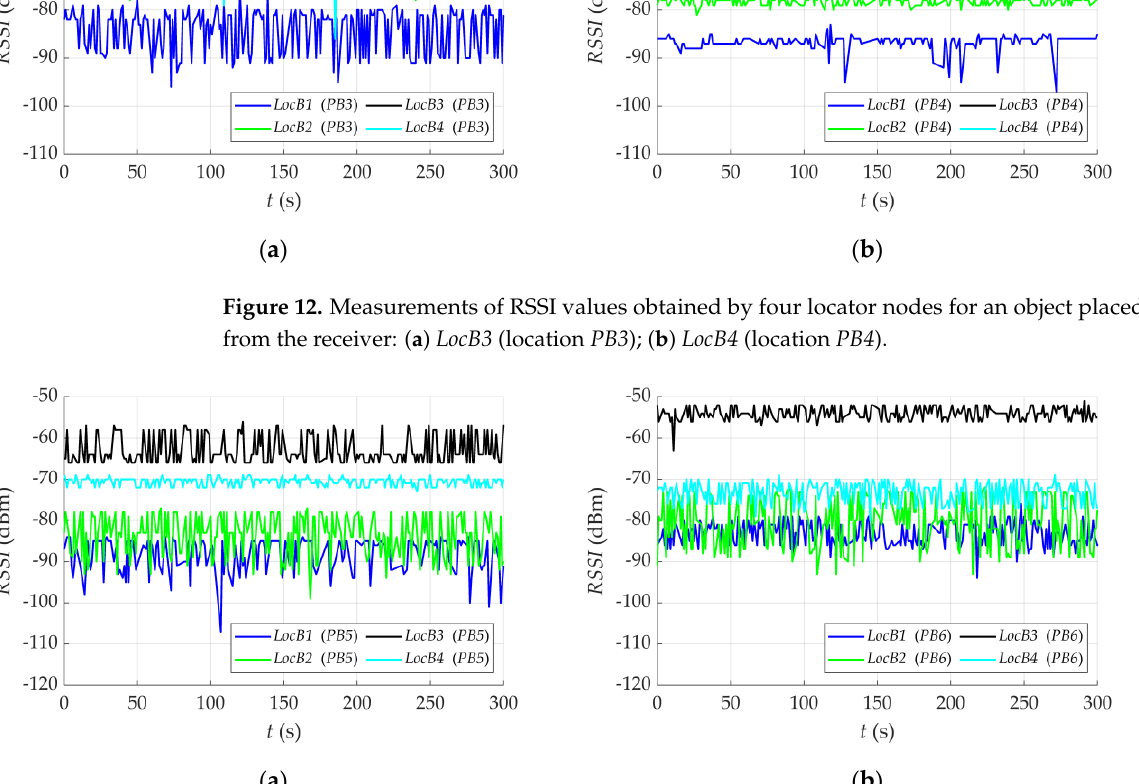
Figure 13. Measurements of RSSI values obtained by four locator nodes for an object placed in front of the LocB3 receiver at a distance of ( a ) 2.5 m (location PB5 ); ( b ) 1.0 m (location PB6 ).